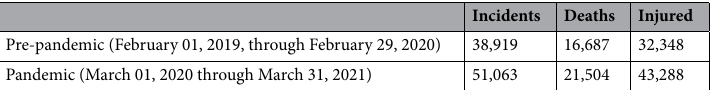
Table 1. The table indicates that there was a 31.2% increase in the number of incidents between the pandemic and pre-pandemic periods.